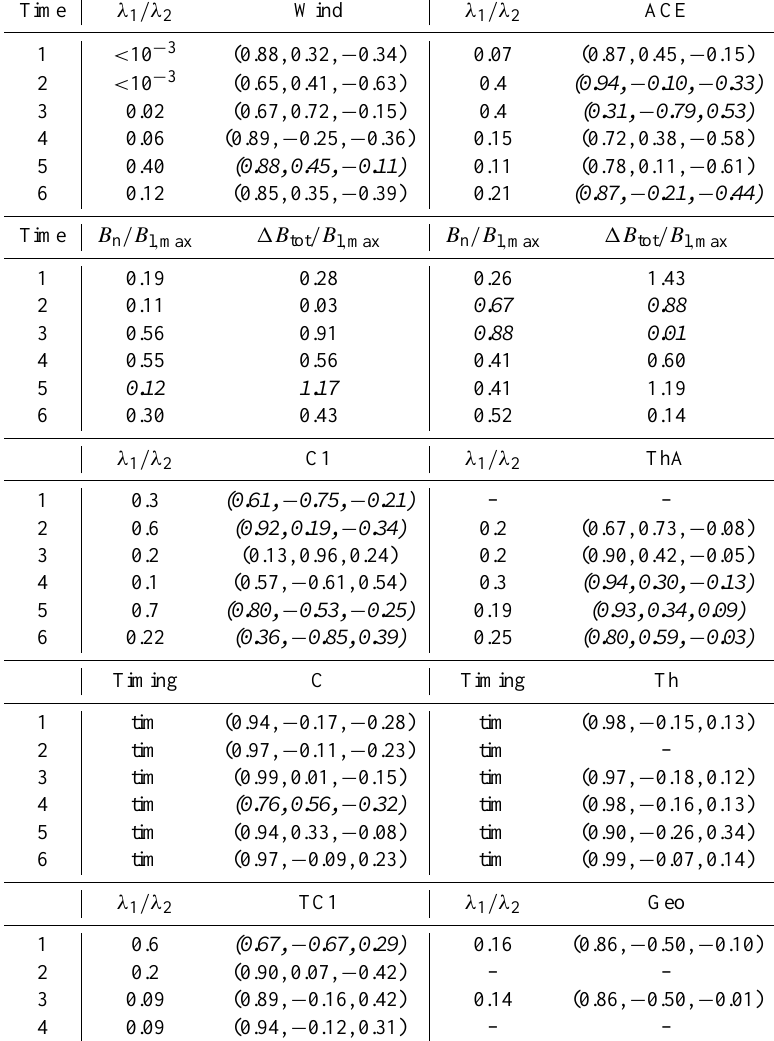
Table 1. Minimum variance directions for the south-north and north-south turnings for the various spacecraft for the intervals marked in Fig. 2, including the ratio of minimum and intermediate eigenvalue and discontinuity parameters. Any values in italics mean that the minimum variance direction was not well